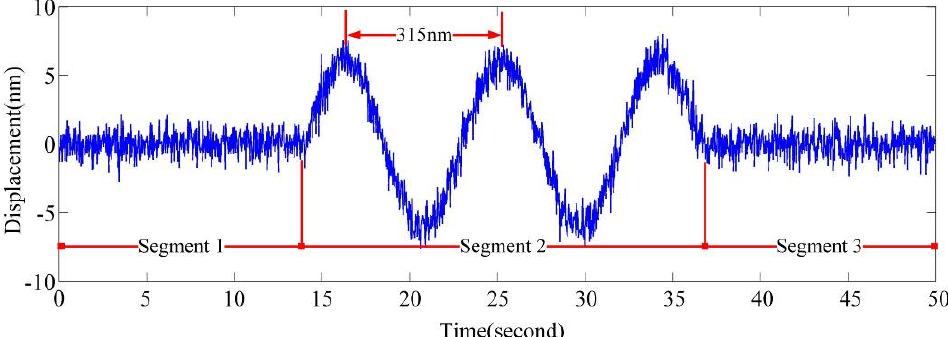
Figure 6. Experimental results of the interferometer for verifying the phase modulation (PM) performance of the EMLMA.